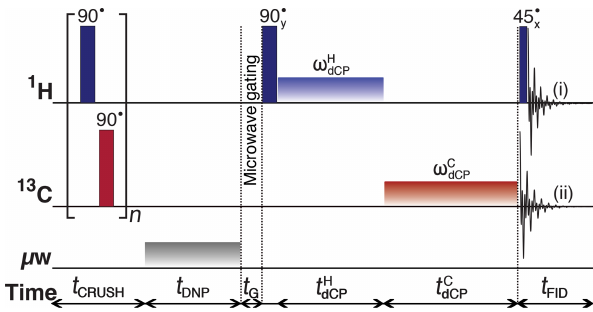
Figure 1. Schematic representation of the d CP rf-pulse sequence used for preparing and monitoring 1 H– 1 H dipolar order in I , and the conversion to 13 C transverse magnetization. The experiments used the following parameters, chosen to maximize magnetization- dipolar order interconversion: n = 250; t DNP = 5s; t G = 0 . 5s; = 25µs; ω C = ω H / 2 π = 16 . 4kHz; t H / 2 π = 13 . 2kHz; t C d CP d CP d CP d CP 39ms. The 1 H and 13 C continuous wave rf pulses have phase x . The π/ 2 crusher rf pulses use a 13-step phase cycle to remove resid- ual magnetization at the beginning of each experiment: { 0 ,π/ 18, 5 π/ 18, π/ 2, 4 π/ 9, 5 π /18, 8 π/ 9, π , 10 π/ 9, 13 π/ 9, π/ 18, 5 π/ 3, 35 π/ 18 } . The resonance offset was placed at the centre of the 1 H and 13 C NMR